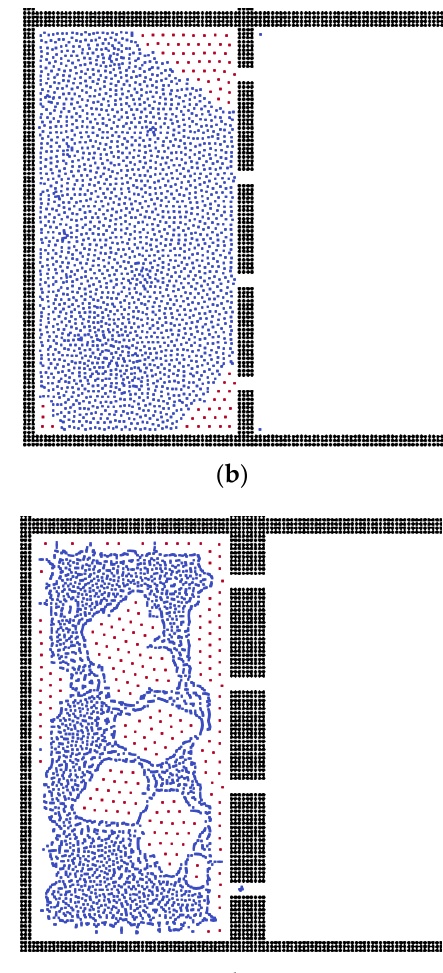
( l ) Figure 5. The results with different channel sizes; ( a , b,e , f , i , j ) with channel width of 12 μ m; ( c , d ), ( g , h , k , l ) and with channel width of 20 μ m.